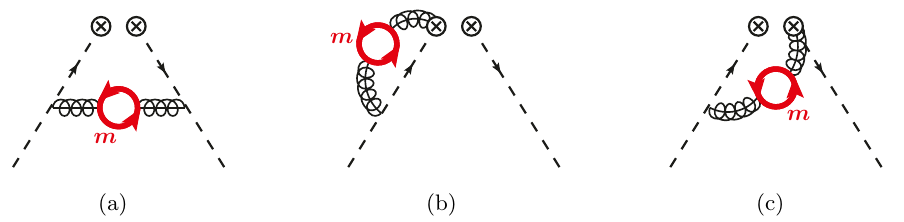
( (cid:11) 2 ). In s O